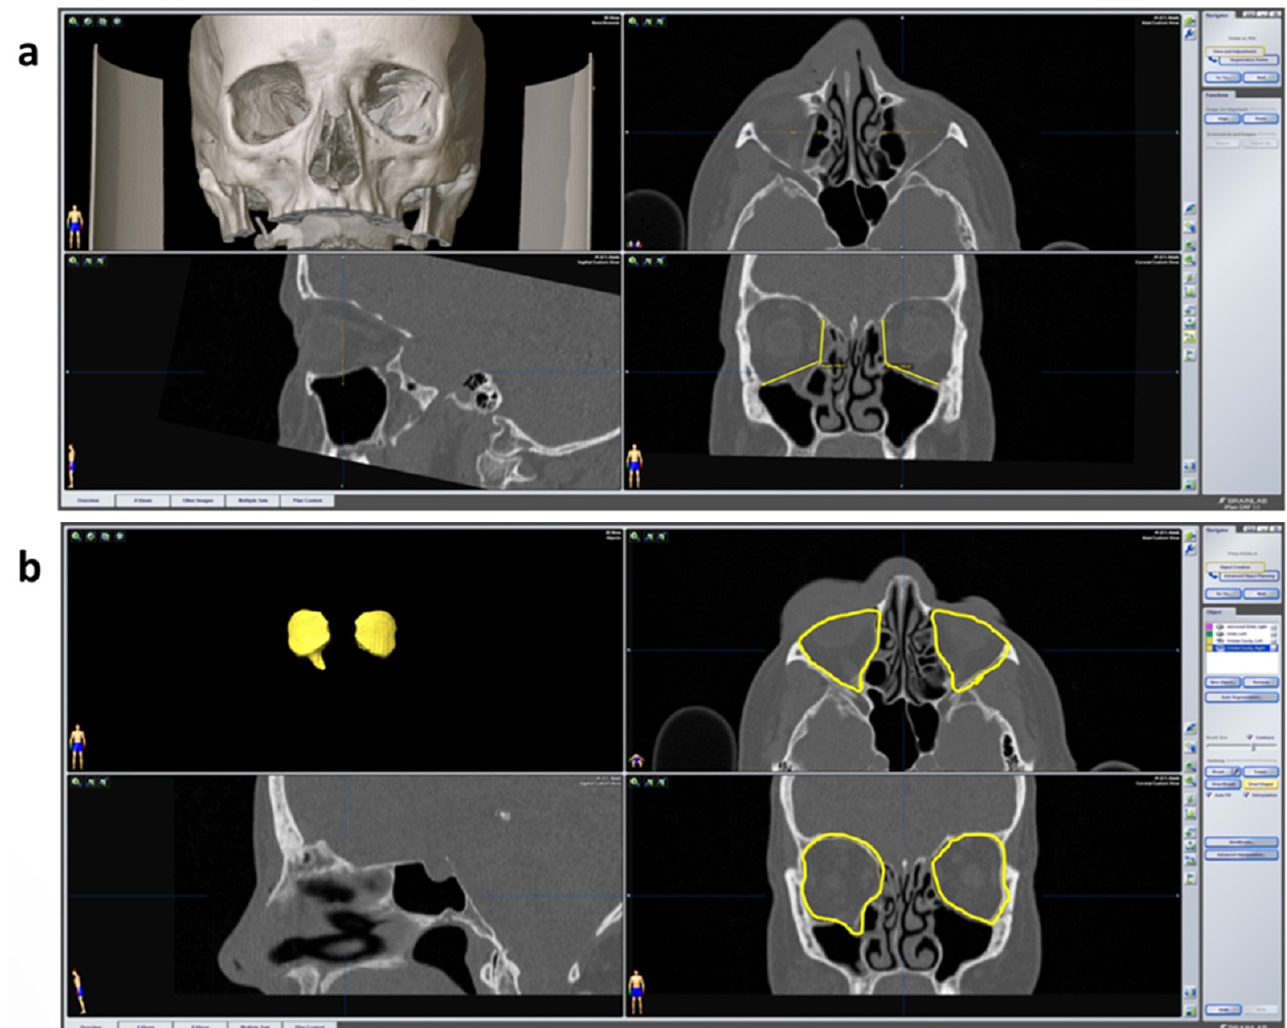
Figure 4. Radiological parameters. ( a ) Angle measurement between the medial orbital wall in iPlan CMF 3.0.5. in coronary layer. The datasets are shown in multi-planar view including 3D reconstruction, axial, sagittal and coronary plane. At the bottom right, the angles of both orbits can be seen in yellow. The values are automatically calculated by the program and displayed. ( b ) Orbital cavity algorithm for automatic volume calculation in iPlan CMF 3.0.5. At the top left the segmented orbital cavities are displayed in 3D volume. On the upper right (axial) and bottom right (coronary), the outlines of the orbits are shown in yellow created via the “smart shaper” function. The right orbital content herniates into the maxillary cavity (“drop-shape”) due to the fracture of the orbital floor.